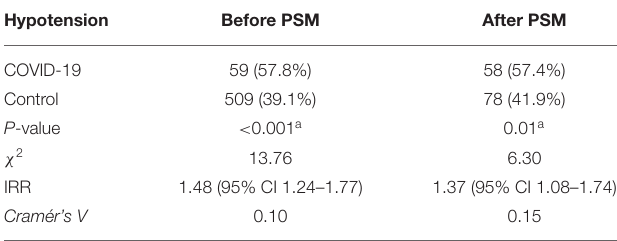
TABLE 3 | Anesthetic implementation and administration in COVID-19 group vs. Control group after propensity score matching